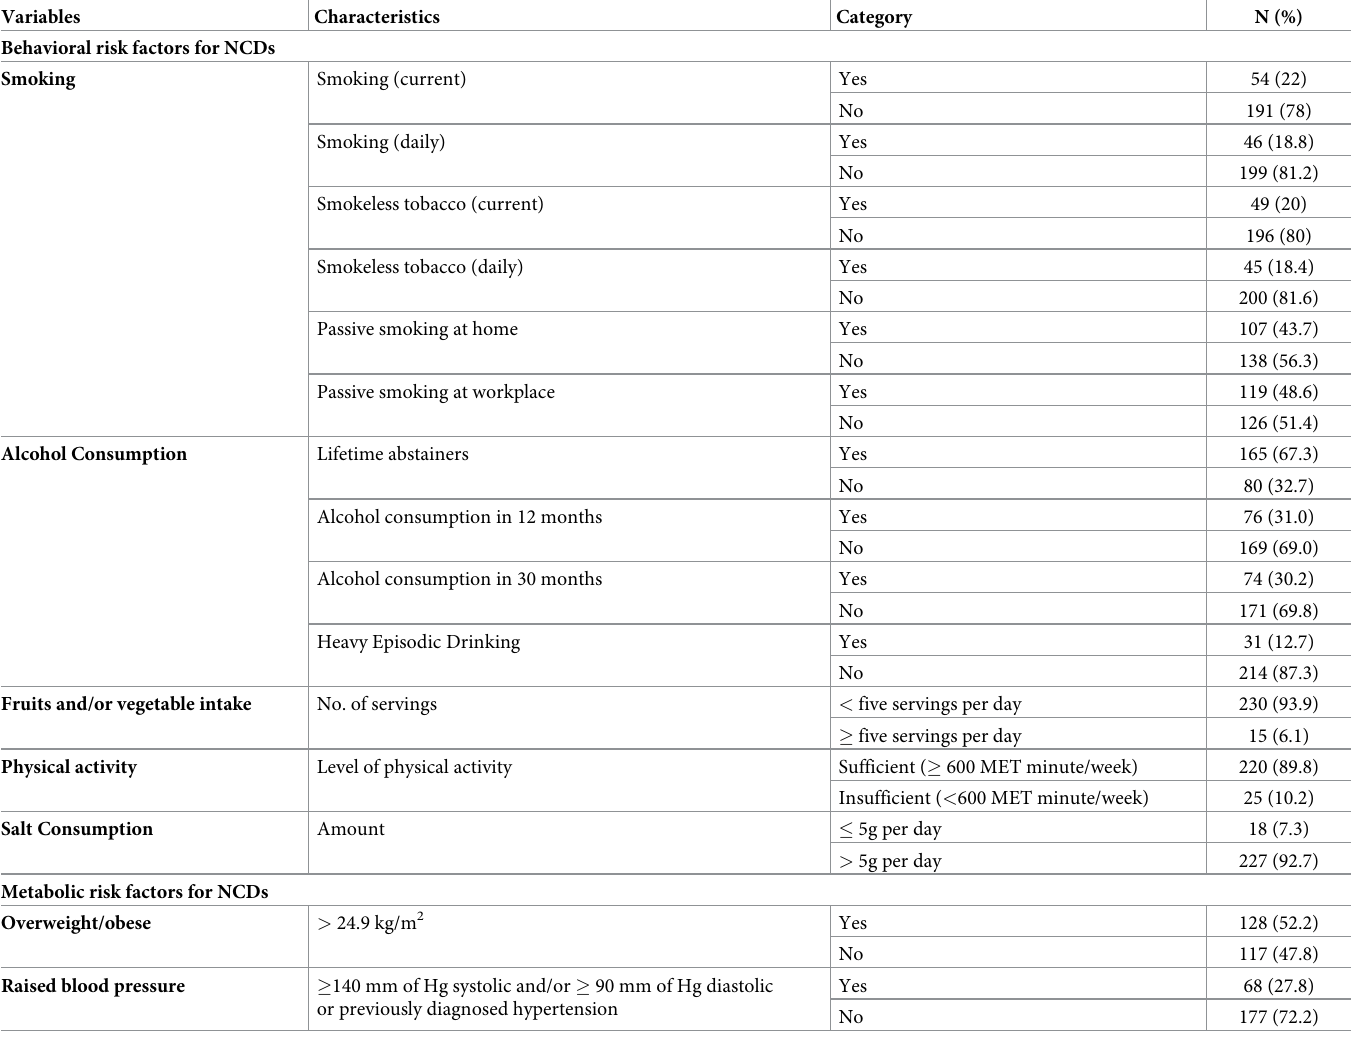
Table 2. Prevalence of NCD risk factors among adult population of Kathmandu n =